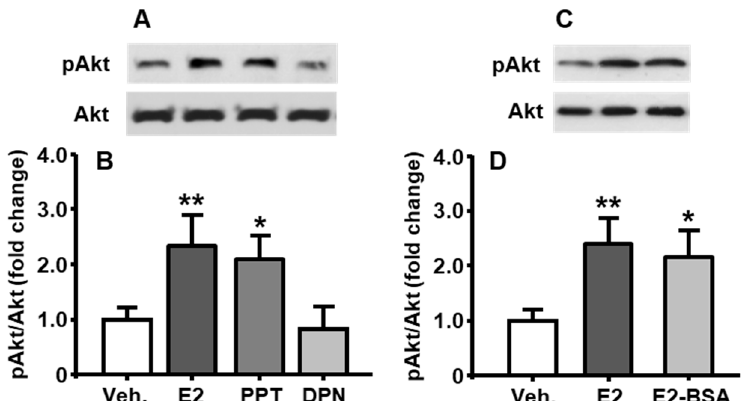
Figure 2. Comparison of PI3K/Akt pathway activation after different treatments in cultured neuronal cells. E2, PPT, but not DPN (all at 10 nM), significantly increase pAkt levels at 30 min ( A , B ). E2-BSA (10 nM) also increased the phosphorylation of Akt ( C , D ). Mean ± S.E., n = 3–4. * p < 0.05, ** p < 0.01 compared to pAkt level after vehicle treatment.